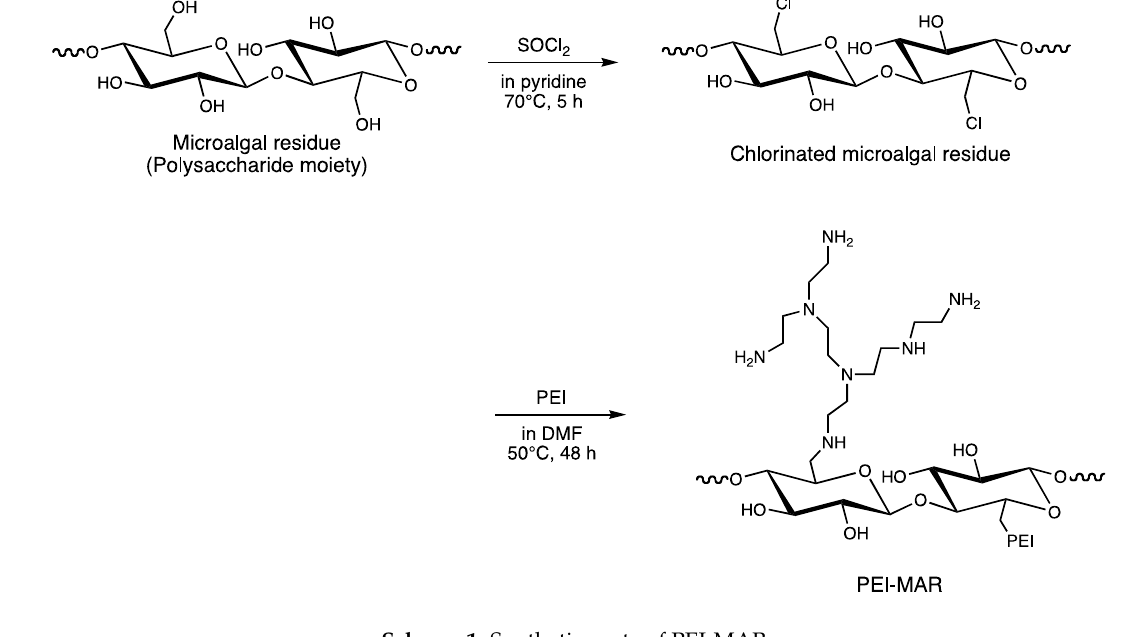
Scheme 1. Synthetic route of PEI ‐ MAR.